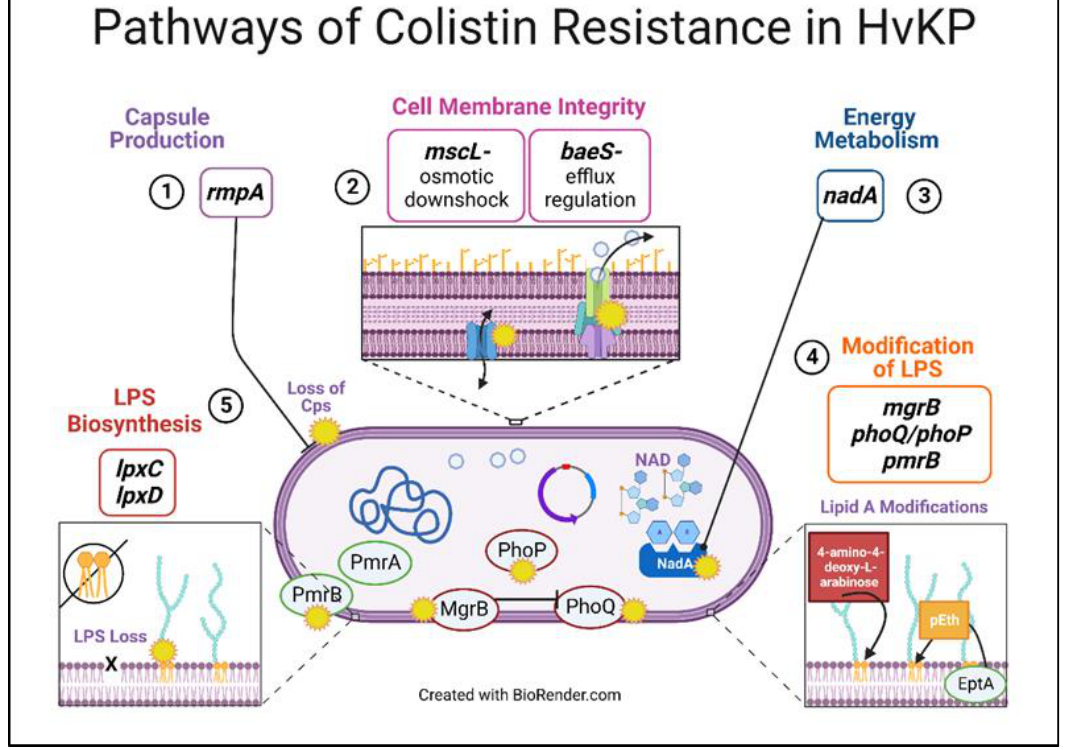
Figure 5. Theoretical pathways of colistin resistance in hypervirulent- K. pneumoniae . Colistin selection led to changes in five major gene functional groups, possibly in a sequential manner in both bacterial lifestyles: capsule production, cell membrane integrity, energy metabolism, modifications of LPS, and LPS biosynthesis loss. We posit that the mutations related to these functional groups facilitate and allow for enhanced colistin resistance in K. pneumoniae